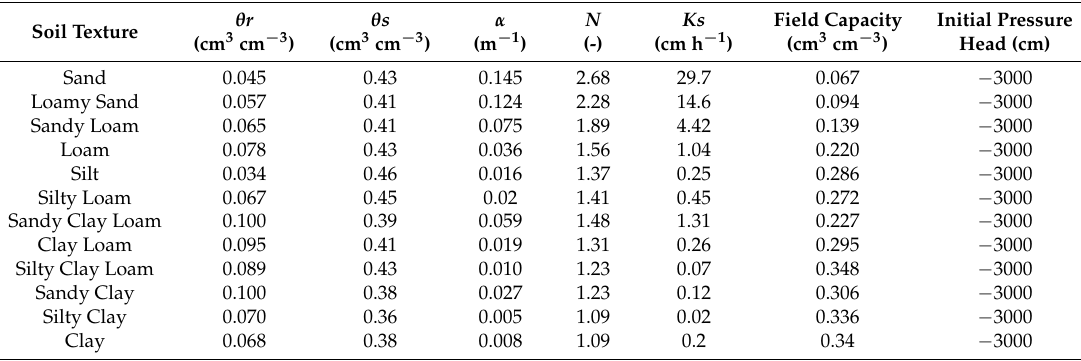
Table 3. Hydraulic parameters of 12 representative soils.